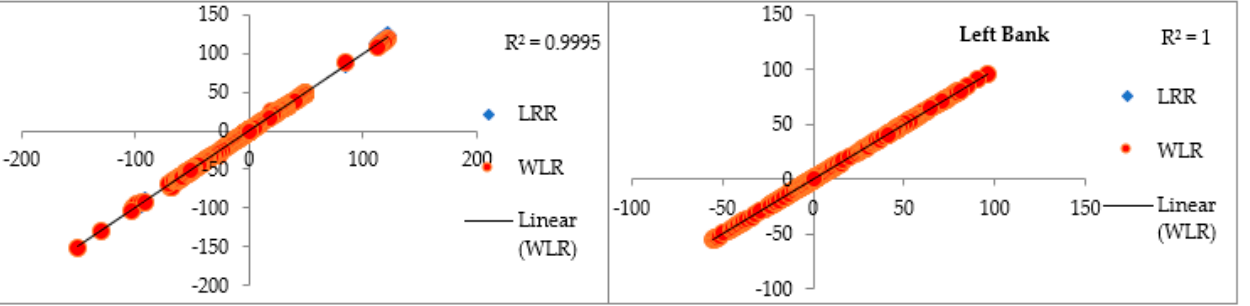
Figure 11. R-square statistics for shoreline change rate.